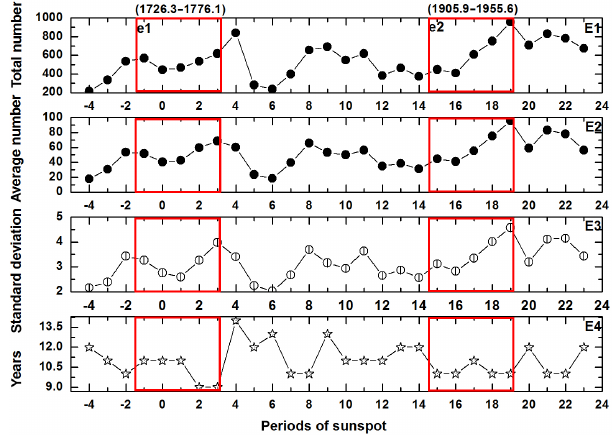
Figure 8. Prolonged minima of solar activity corresponding to the disorderly orbit of the planetary